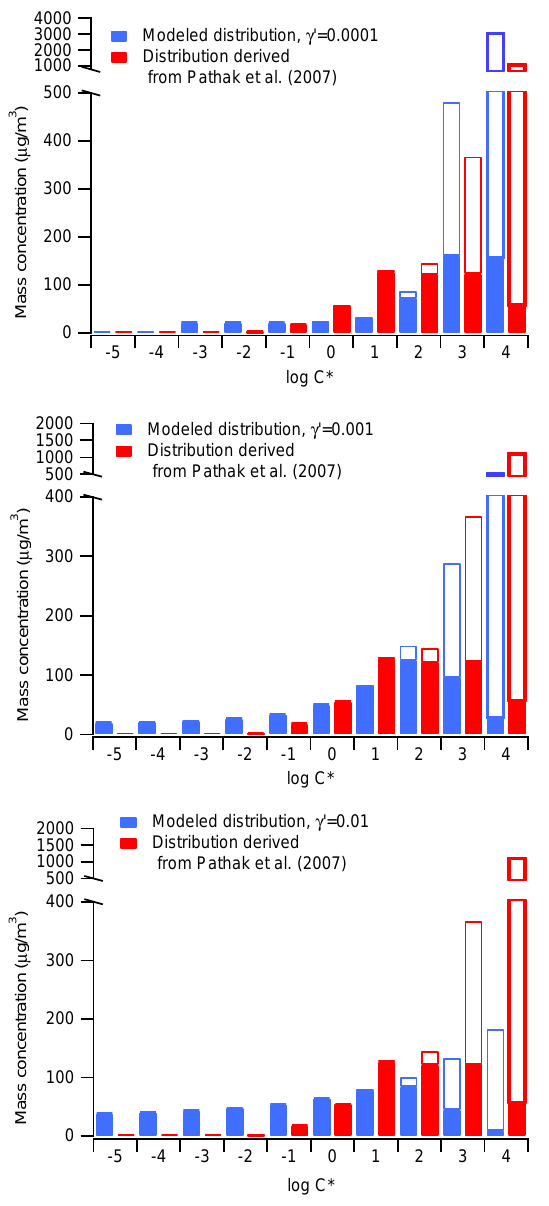
Fig. 16. Volatility distributions derived from α -pinene SOA ther- mograms at 500µgm − 3 aerosol loading using the kinetic model ap- proach with different kinetic coefficient values, in comparison with the distribution derived from data by Pathak et al. (2007). The de- rived distribution is sensitive to the assumption of effective kinetic coefficient, with a shift towards lower volatility for increasing ki- netic